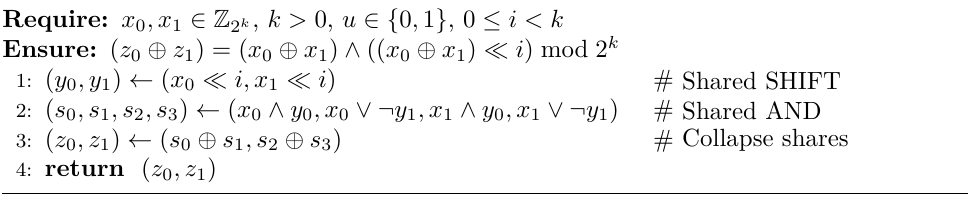
Algorithm 11 Kogge-Stone Optimized 2-Share